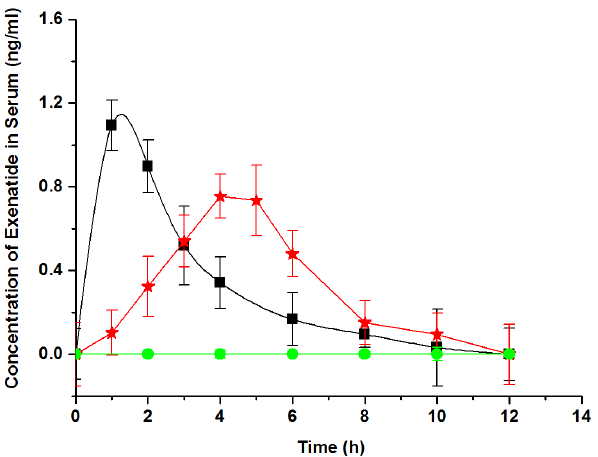
Figure 5. Pharmacokinetic study of exenatide-loaded micro- spheres in db/db mice. Free exenatide solution administered by subcutaneous injection (50 m g/kg) (black square); Oral administration of blank microspheres blending with free exenatide solution (500 m g/kg) (green circle); Oral administration of exenatide-loaded microspheres (cross-linking for 0.5 h) (red star). Each group consisted of 8 db/db mice.